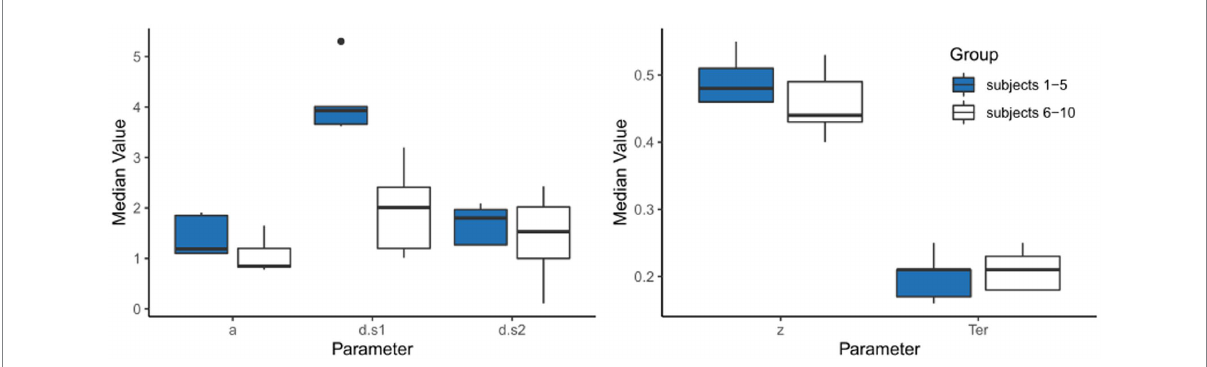
FIGURE 10 Box-and-whiskers plots showing DDM estimated parameter results from 10 data files, using MLE. (Left) Boundary separation a and drift rates d for s1 and s2, all in arbitrary units. For easy comparison, drift rates are plotted as absolute values; the actual value of d.s1 < 0 reflects slope downward to r1 boundary while d.s2 > 0 reflects slope upward to r2 boundary. (Right) Relative starting point z (as a proportion of a) and non-decision time Ter (in seconds). Heavy lines indicate median; boxes indicate interquartile range (IQR); whiskers indicate range; dots indicate scores lying >1.5 IQR beyond the